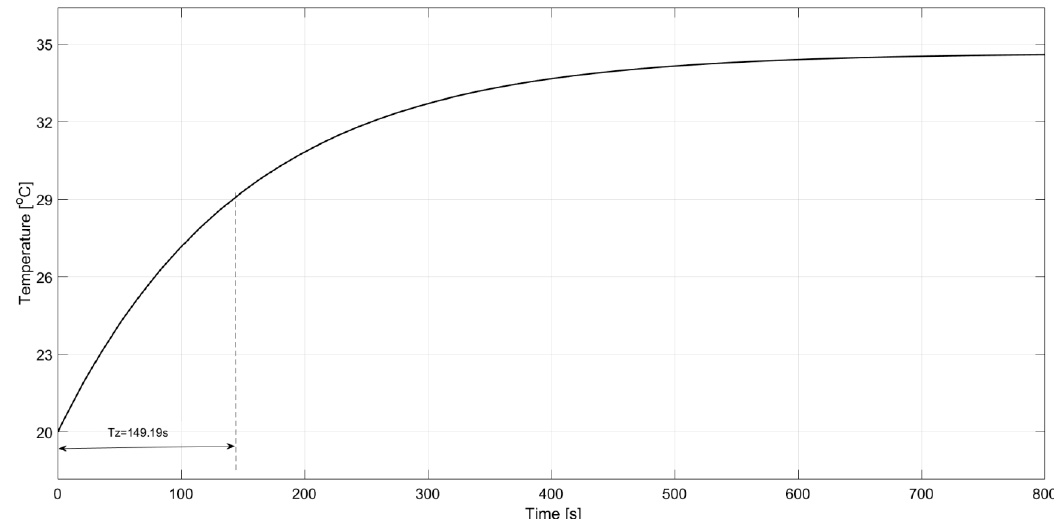
Figure 16. Efficiency characteristics of a battery of 20 collectors heat loaded with a 1000 dm 3 storage tank.